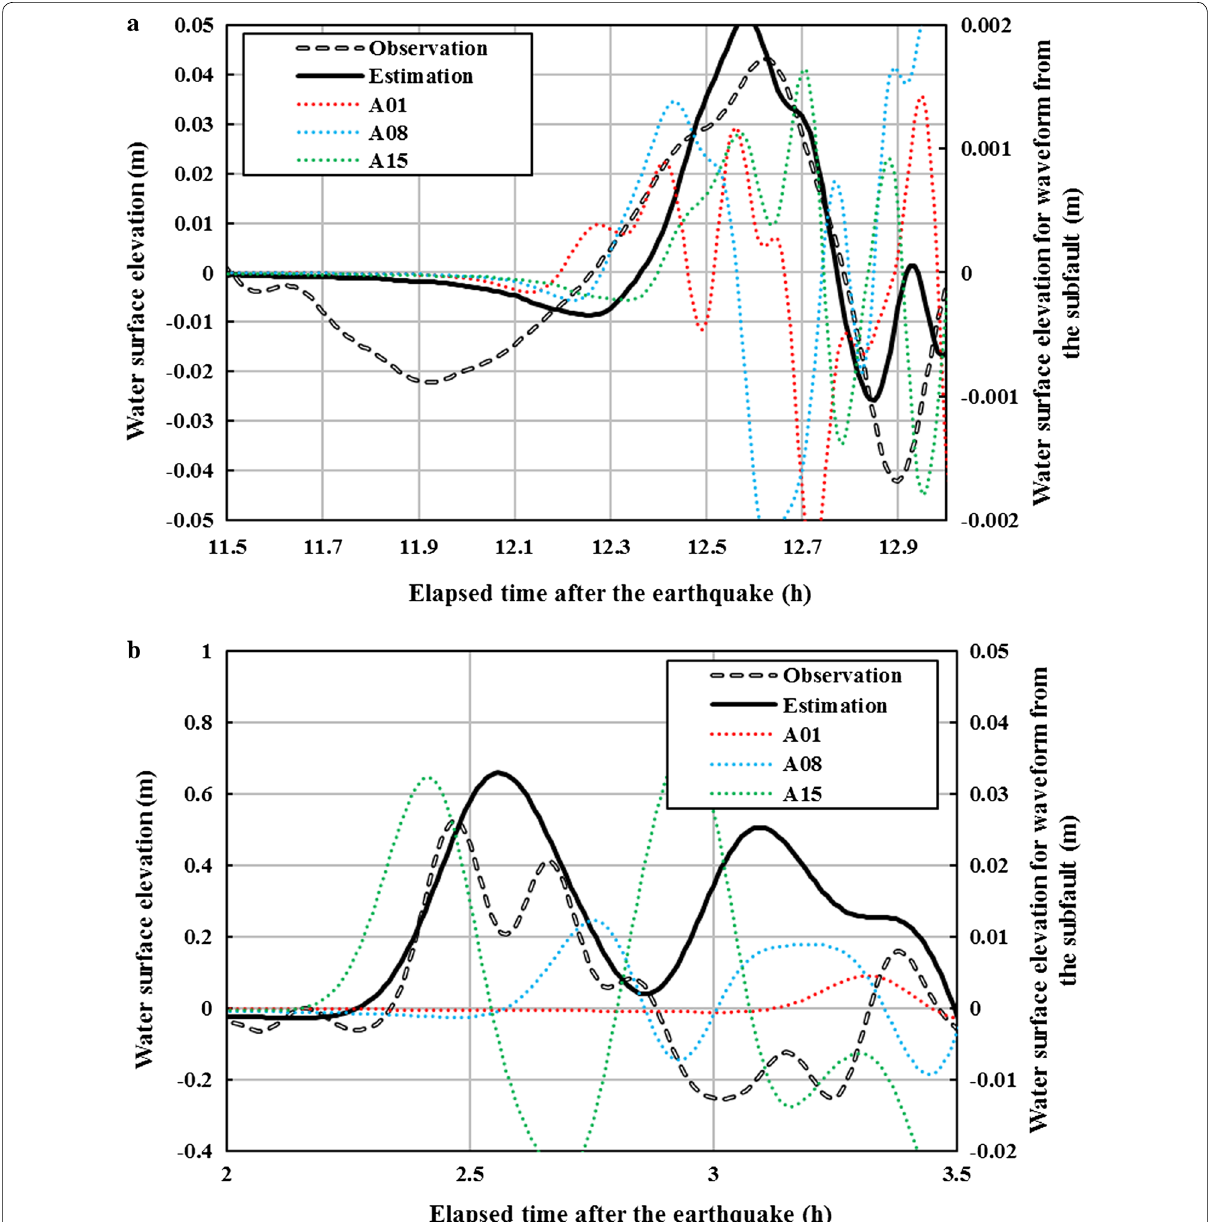
Fig. 2 Comparison of the estimated and observed waveforms at a Honolulu and b Naos Island. A01, A08, and A15 are slip locations defined by the grid shown in Fig.